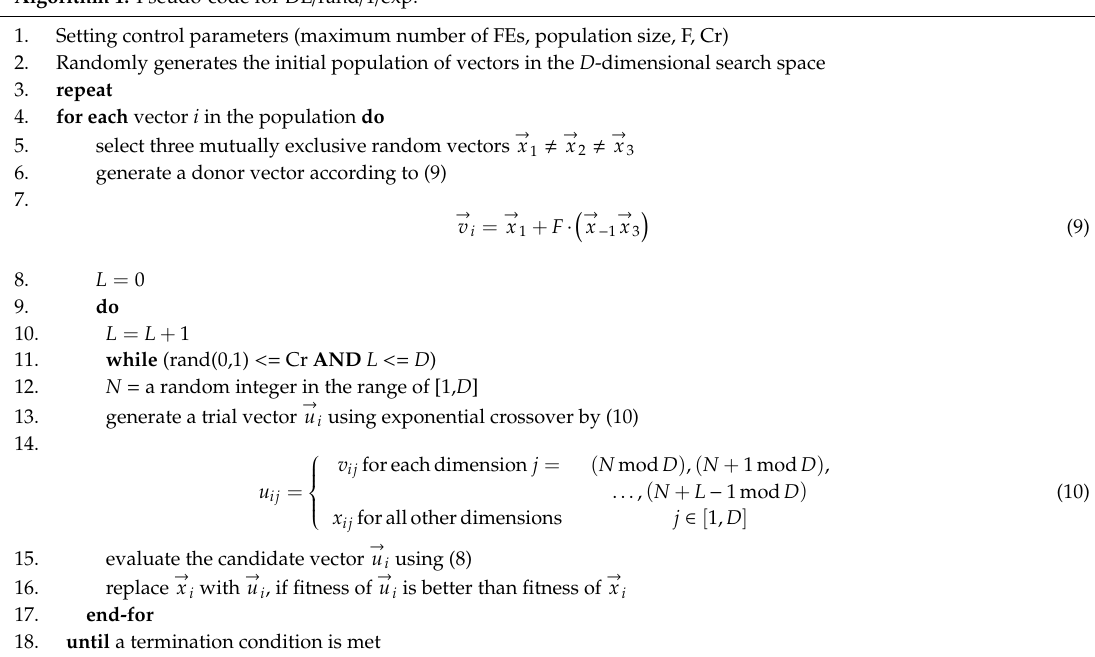
Algorithm 1. Pseudo-code for DE / rand / 1 /